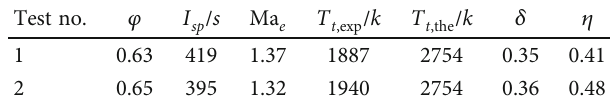
Table 3: Performance parameters of the scramjet combustor. Test